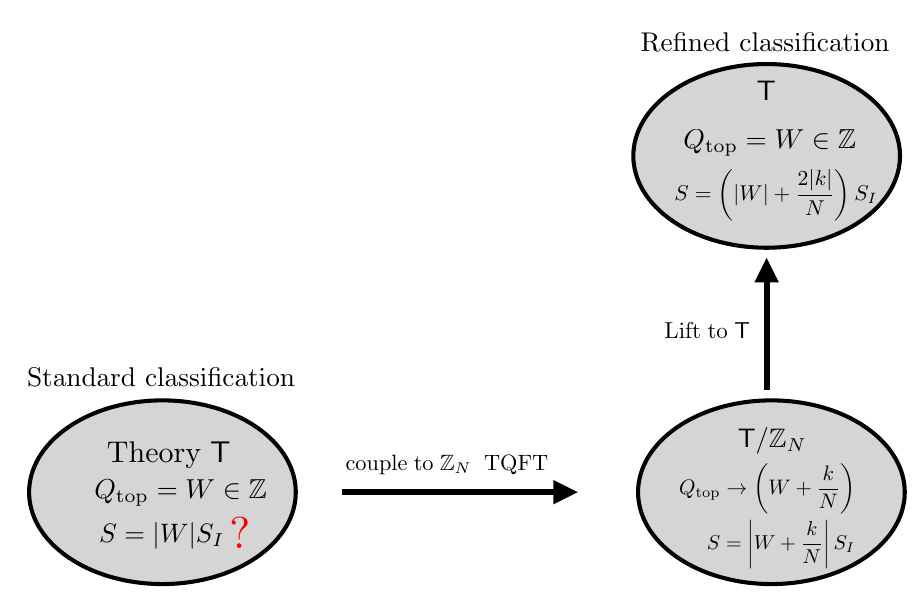
Figure 1 . By coupling a QFT to a TQFT, the topological charge and action become fractional. Such configurations do not lift to the partition function of the theory T , but their integer topological charge and fractional action composites do. Even the W = 1 fractional instantons contribute to N some observables in T , but not to partition function. We demonstrate that the non-perturbative expansion parameter in theory is exp[ − S ] instead of exp[ − S ] . This statement was already I /N I known to be true in semi-classical domain. The TQFT coupling tells us that it is also true in strong coupling